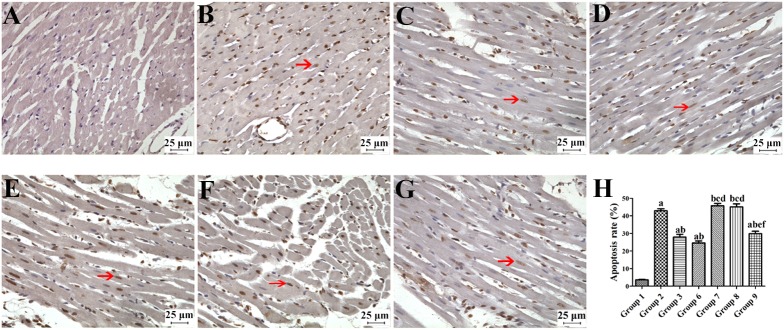
TUNEL apoptotic staining of the myocardial tissue (×200).(A) Group1; (B) Group 2; (C) Group 3; (D) Group 6; (E) Group 7; (F) Group 8; (G) Group 9; (H) Average of apoptosis rates in different groups. (Red arrow: apoptotic cell; Data were expressed as mean ± SD, n = 10; a: P < 0.05, vs. group1; b: P < 0.05, vs. group2; c: P < 0.05, vs. group3; d: P < 0.05, vs. group6; e: P < 0.05, vs. group 7; f: P < 0.05, vs. group 8).